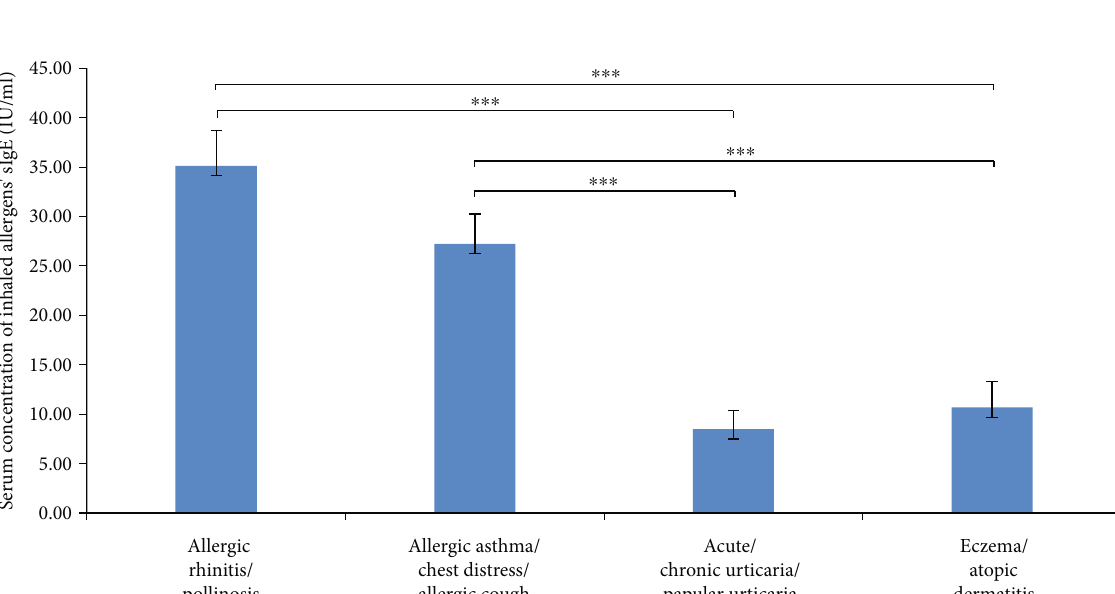
Figure 3: Mean value of inhaled allergen ’ s sIgE in di ff erent diseases ( ∗∗∗ p < 0 : 001